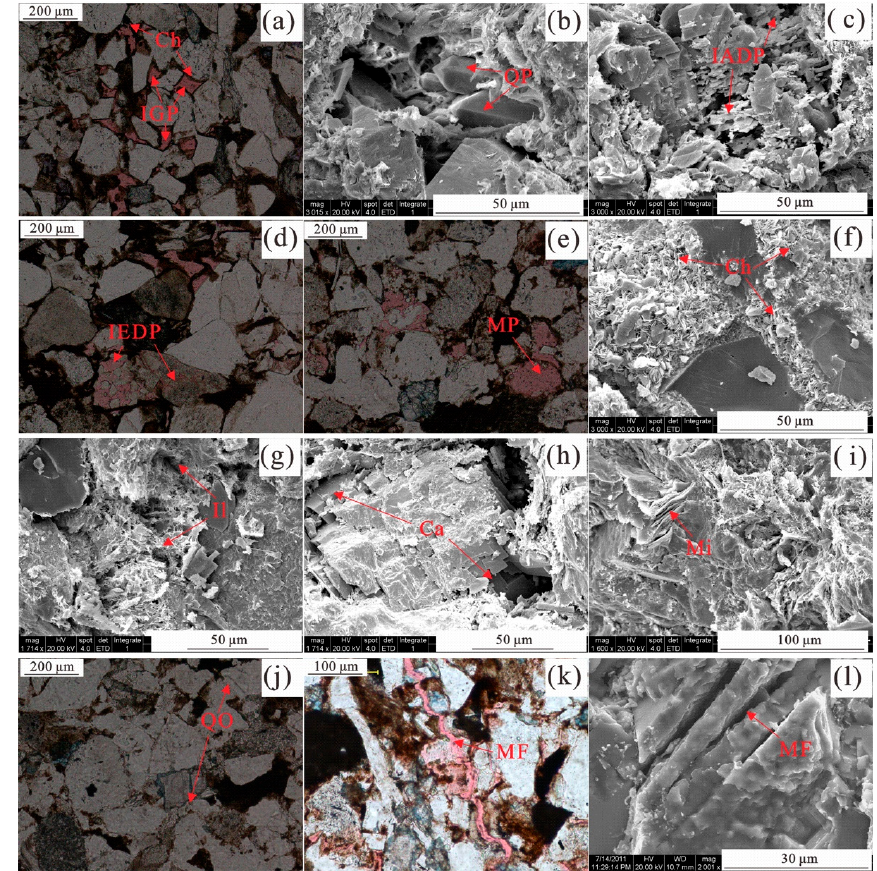
Figure 2. Typical pore types from Yanchang formation sandstones: ( a ) Plane-polarized light view of intergranular pore and presence of pore-lining chlorite; ( b ) SEM image of quartz prisms; ( c ) plane-polarized light view of intragranular dissolution pore; ( d ) plane-polarized light view of intergranular pore; ( e ) plane-polarized light view of moldic pore; ( f ) SEM image of pore-filling chlorite; ( g ) SEM image of illite; ( h ) SEM image of carbonate; ( i ) SEM image of mica; ( j ) plane-polarized light view of quartz overgrowth; ( k ) plane-polarized light view of microfracture; ( l ) SEM image of microfracture. IGP — intergranular pore; Ch — chlorite; QP — quartz prisms; IADP — intragranular dissolution pore; IEDP — intergranular dissolution pore; MP — moldic pore; Il — illite; Ca — carbonate; Mi — mica; QO — quartz overgrowth; MF — microfracture.